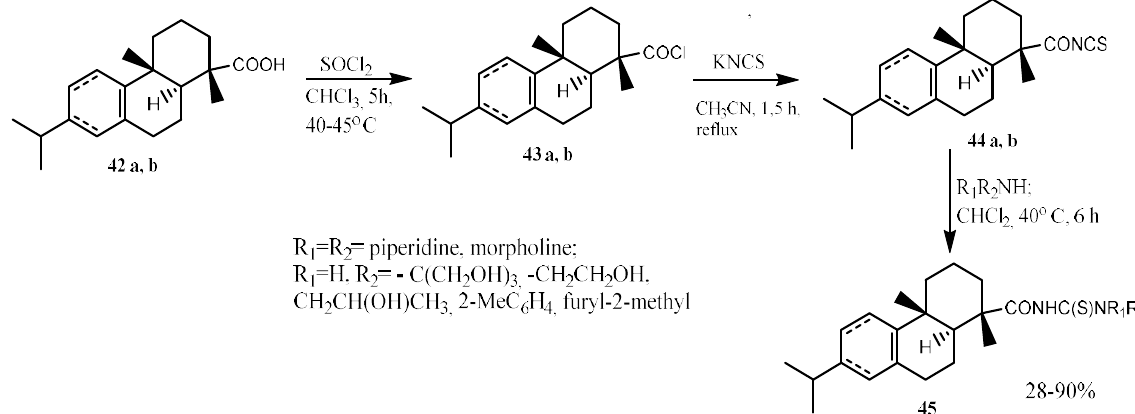
Fig. 13. Synthesis of N- (quinolin-3-yl)carbamothioyl)acyl-(aroyl-)amides effective inhibitors of fungal tyrosinase